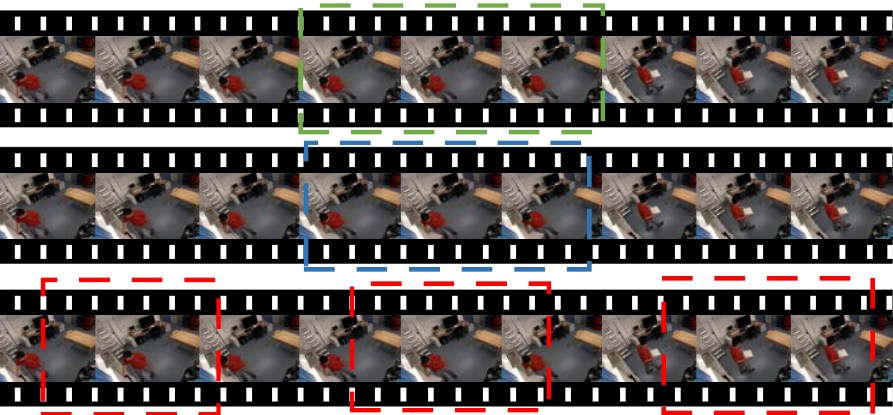
Figure 4. Action instance. The green box represents ground truths, the blue box represents a good prediction, and the red box represents a poor prediction.